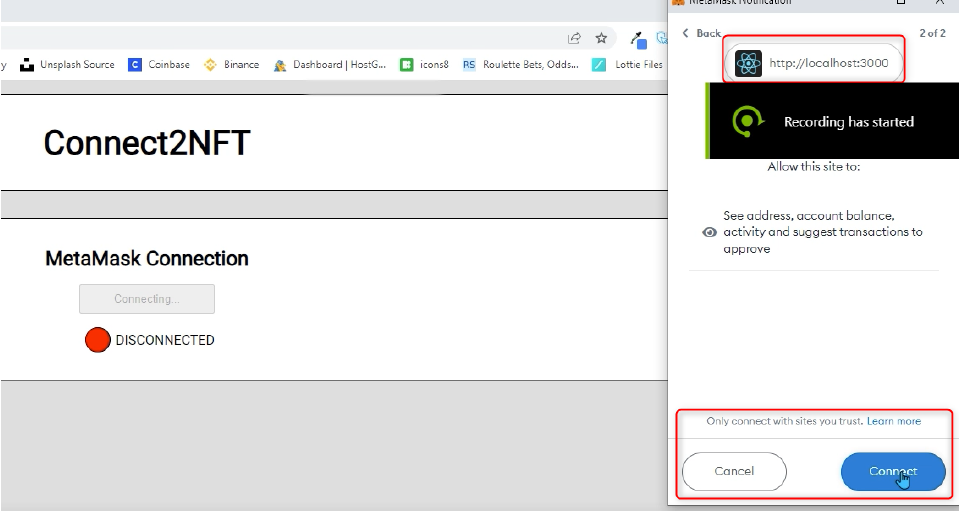
Figure 2. Successful connection to MetaMask